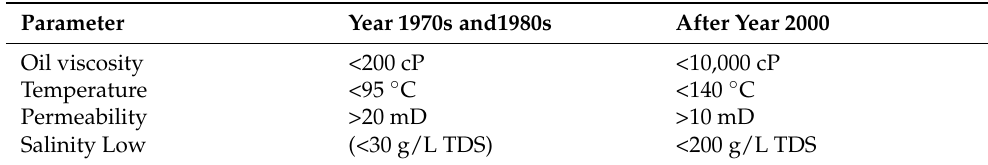
Table 1. Updated screening criteria for polymer flooding (Data are taken from Antoine Thomas, 2016